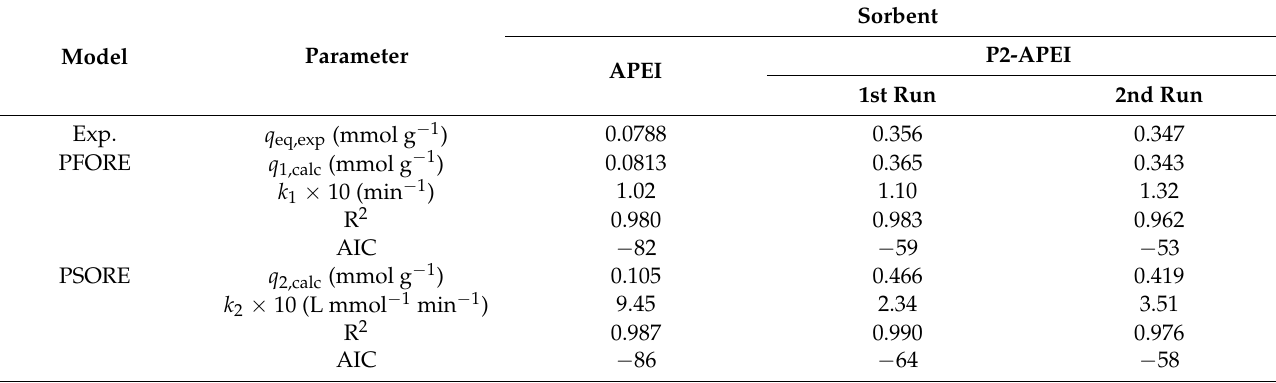
Table 6. Pr(III) desorption kinetics using APEI and P2-APEI sorbents—fitting parameters for the PFORE and PSORE models.